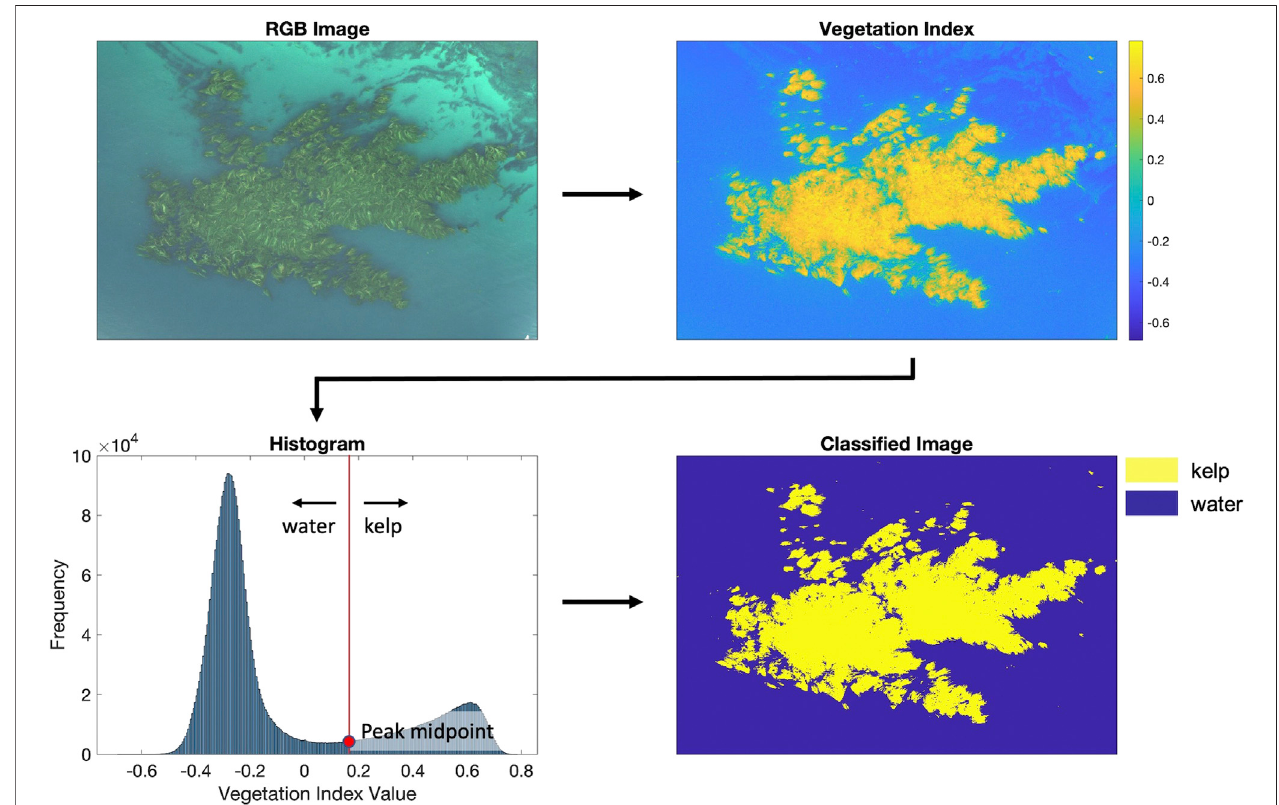
FIGURE 4 | Methodology used in the detection of the presence or absence of kelp in each pixel. For each image, we applied the vegetation index (Red-Blue and NDREB) and calculated histograms to fi nd unique thresholds for image classi fi cations.